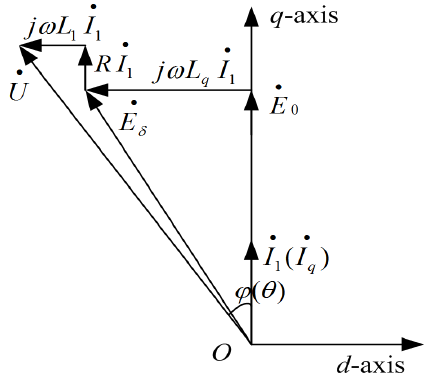
Figure 10. Phasor diagram of the machine under i d = 0 control strategy.